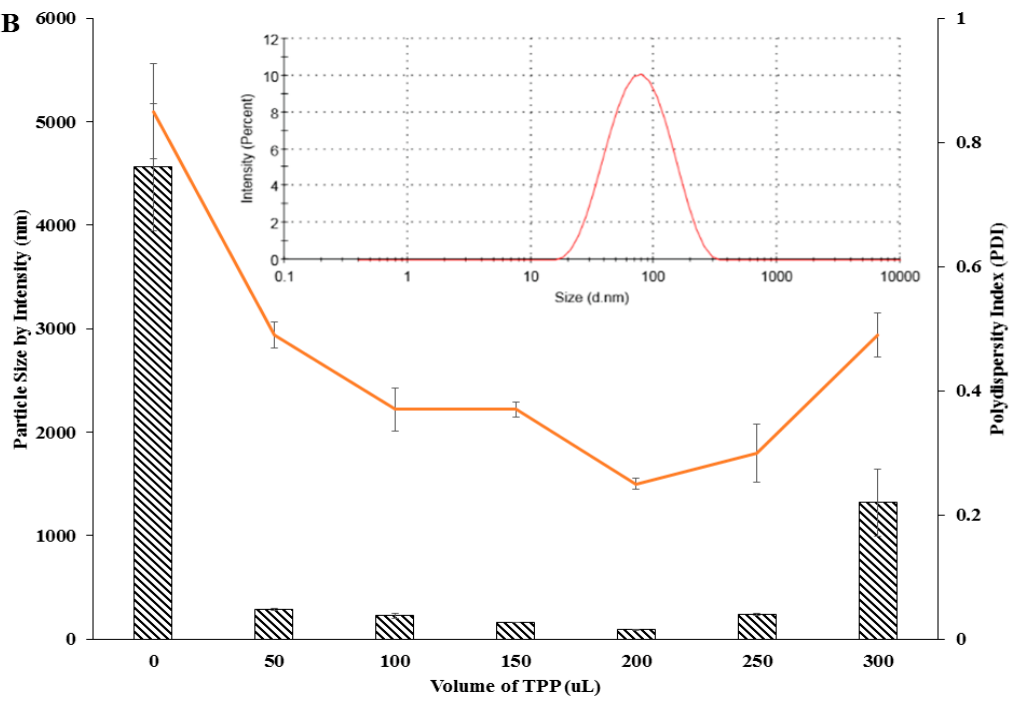
Figure 2. The PSD and PDI value of ( A ) CNP and ( B ) pCNP at different TPP volumes. Represented by bar (particle size) and line (PDI value) graphs. The smallest size of 82.24 ± 2.67 nm was obtained at 250 µL of TPP for CNP with PDI of 0.25 while 90.23 ± 2.67 nm at 200 µL for pCNP with PDI of 0.25. The DLS graph of CNP and pCNP synthesized by using 250 µL and 200 µL was shown inset in both Figure 2A, 2B, respectively. Error bars represent the SEM averaged from three independent experiment replicates. One-way ANOVA was performed with p > 0.05 for both particle size and PDI indicating no significant difference between the three experimental replicates.